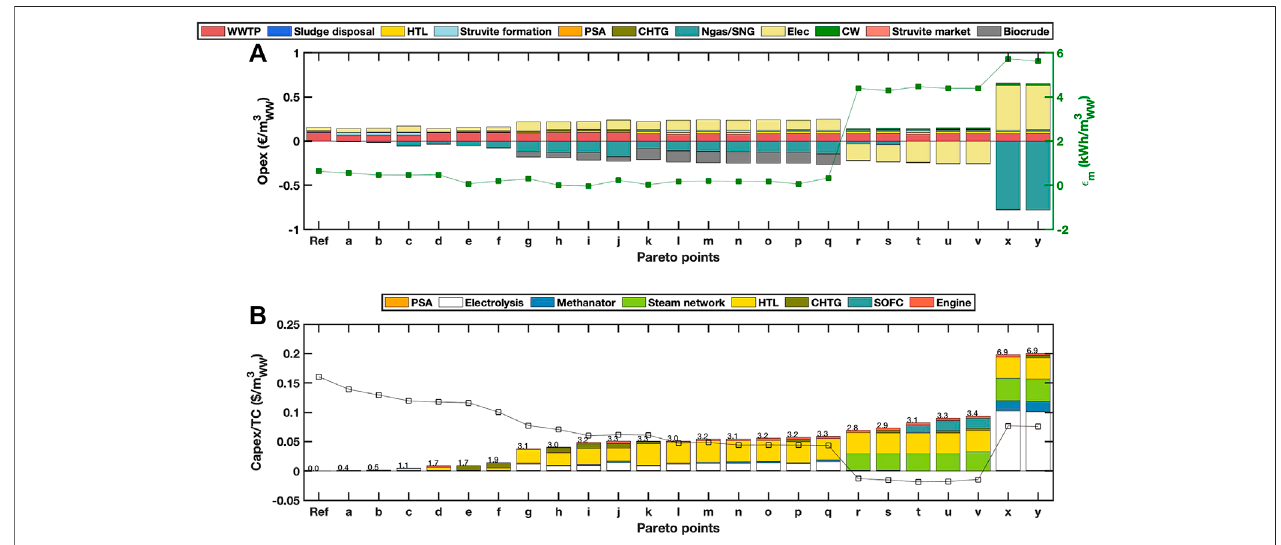
Frontiers in Energy Research |